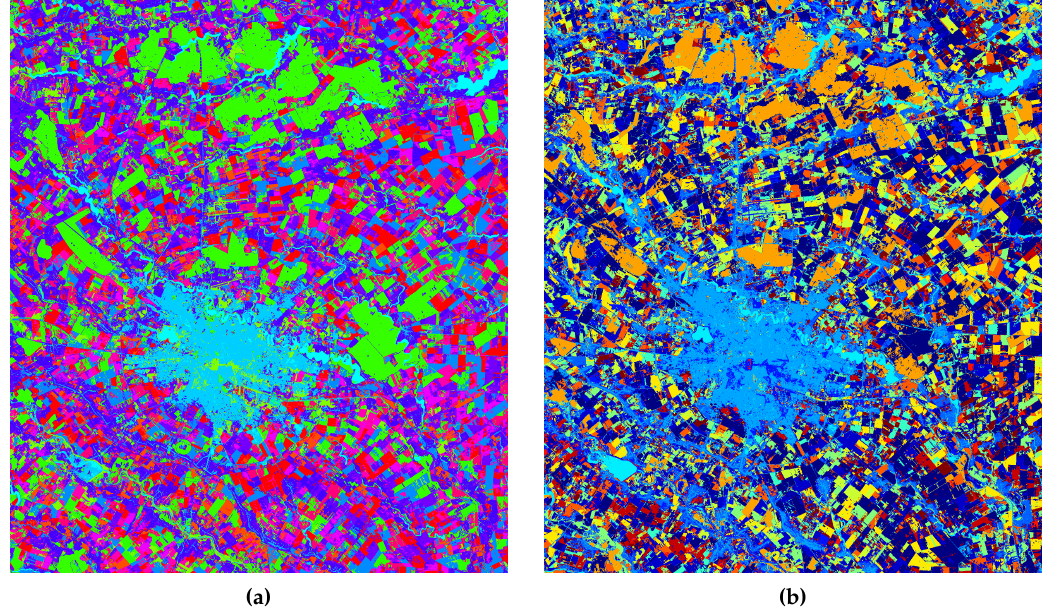
Figure 13. Analysis of short Landsat SITS: ( a ) DTW-based K-means clustering [7], ( b ) LDA-based clustering [12].